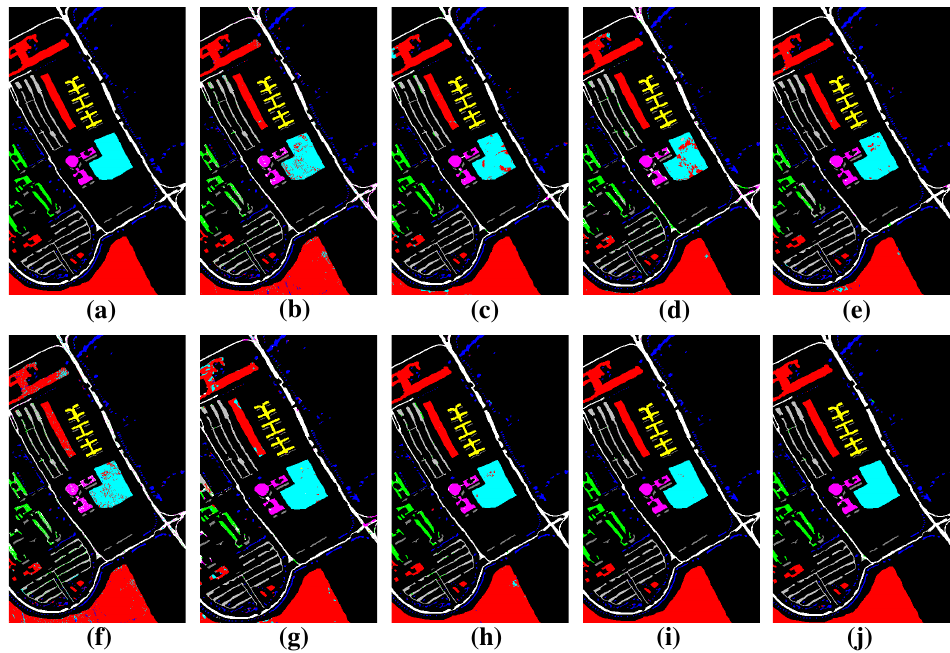
Figure 11. Groundtruth and Classification maps with 5% training samples from PaviaU dataset. ( a ) Groundtruth; ( b ) SVM; ( c ) EMP-SVM; ( d ) SAE-LR; ( e ) CNN-MLR; ( f ) LSTM; ( g )